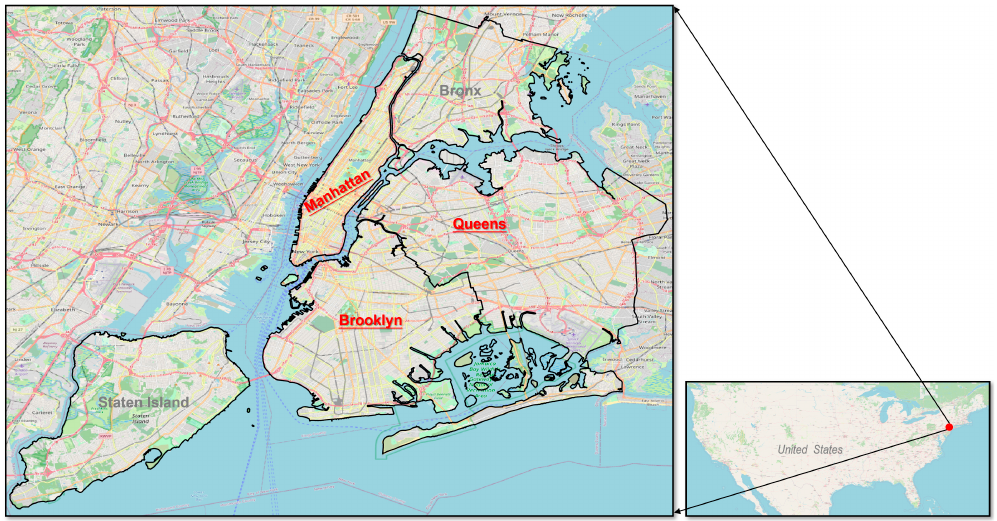
Figure 1. Study area of New York City in this study (areas with red labels have bike stations).